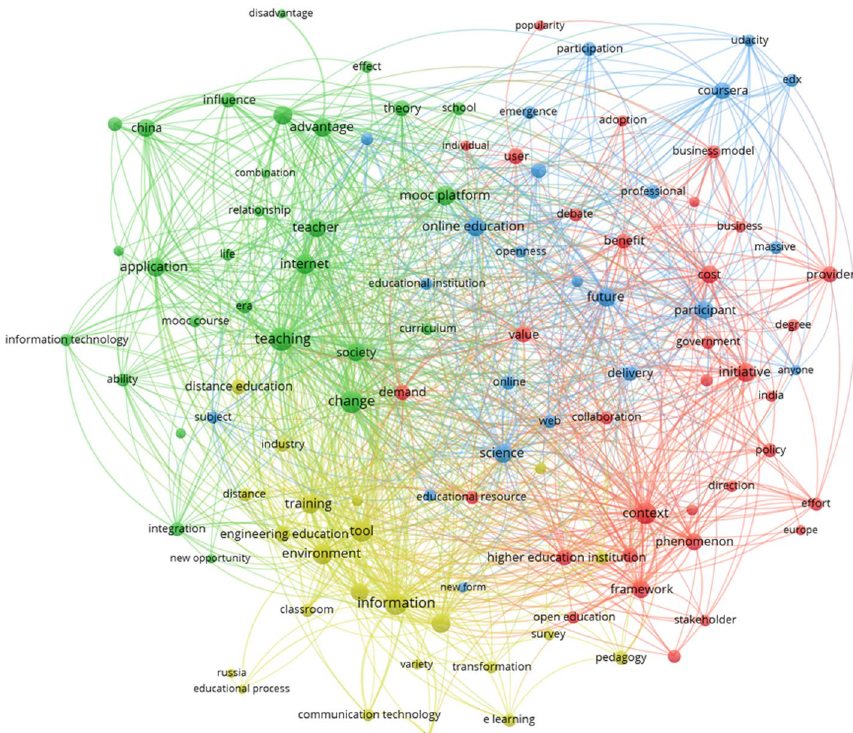
Fig. 3 Thematic cluster institutional approaches about MOOCs. Network